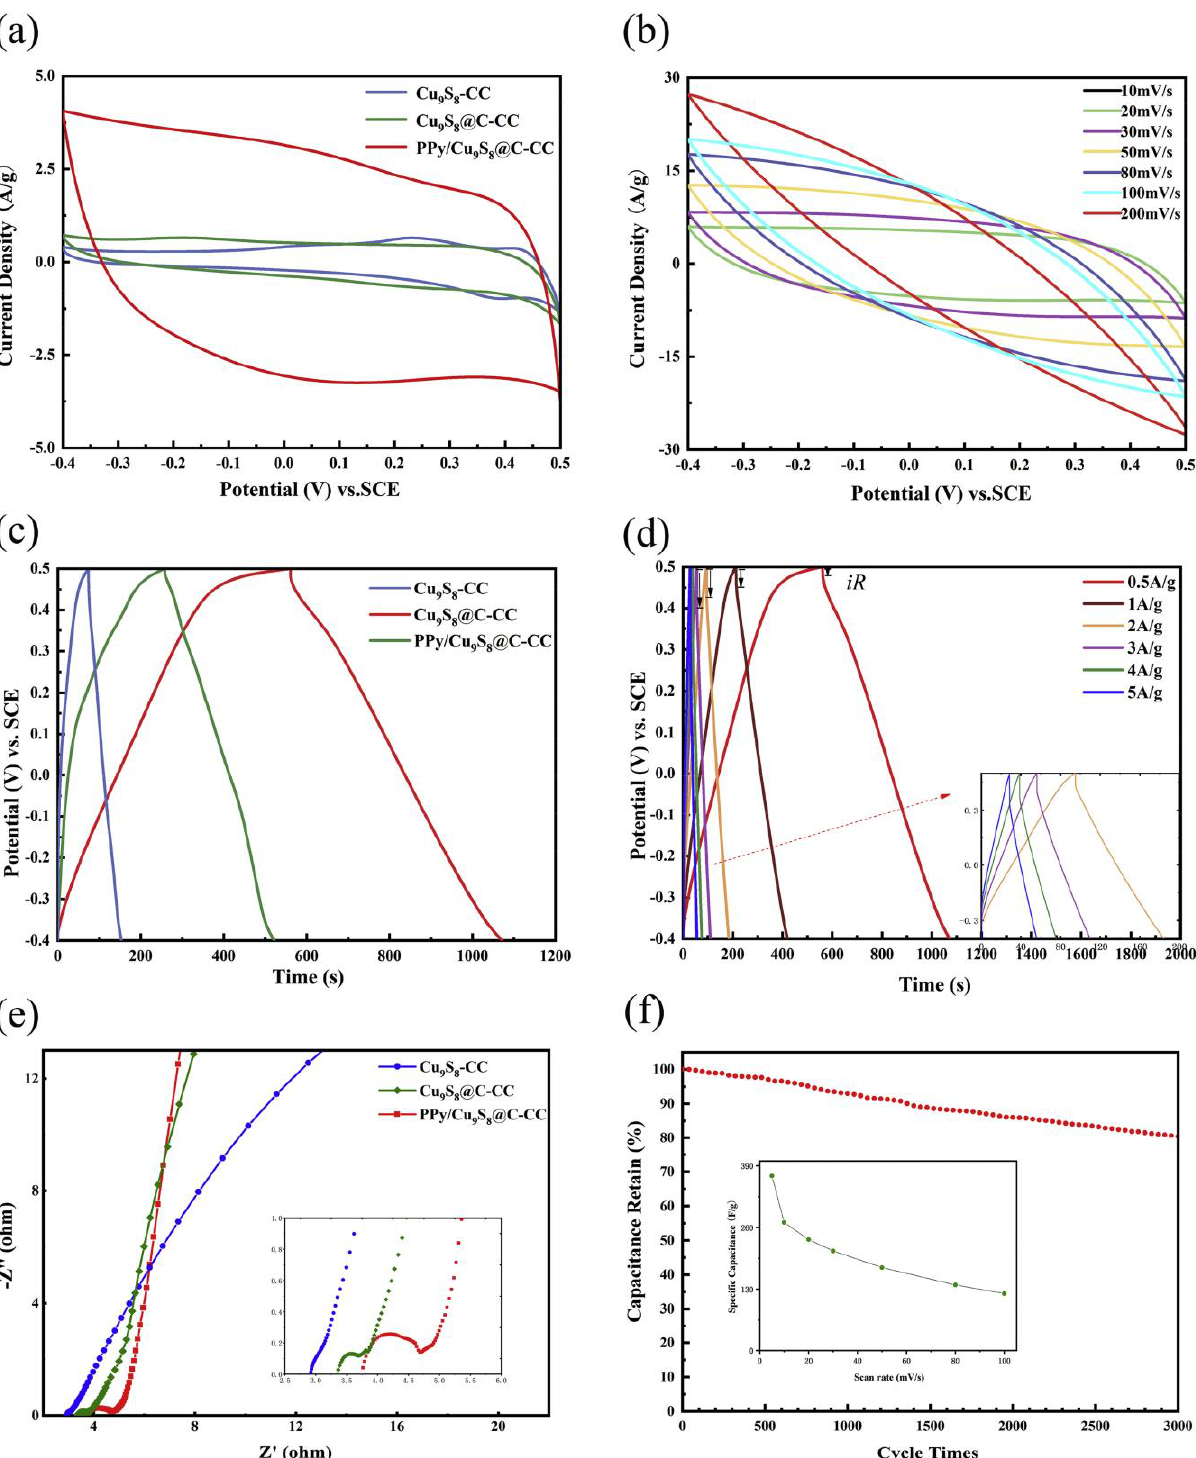
Figure 2. ( a ) CV behaviors of Cu 9 S 8 -CC, Cu 9 S 8 @C-CC, and PPy/Cu 9 S 8 @C-CC electrode. ( b ) CV curves of PPy/Cu 9 S 8 @C-CC electrode at different scan rates. ( c ) GCD curves of Cu 9 S 8 -CC, Cu 9 S 8 @C-CC, and PPy/Cu 9 S 8 @C-CC electrode. ( d ) GCD curves of PPy/Cu 9 S 8 @C-CC electrode at different current densities. ( e ) Nyquist electrochemical impedance spectra of Cu 9 S 8 -CC, Cu 9 S 8 @C-CC, and PPy/Cu 9 S 8 @C-CC electrode. ( f ) Cycling stability of PPy/Cu 9 S 8 @C-CC electrode at 10 mV/s, the insert is variation of specific capacitance at different scan rates [43]. Copyright 2019 Elsevier.